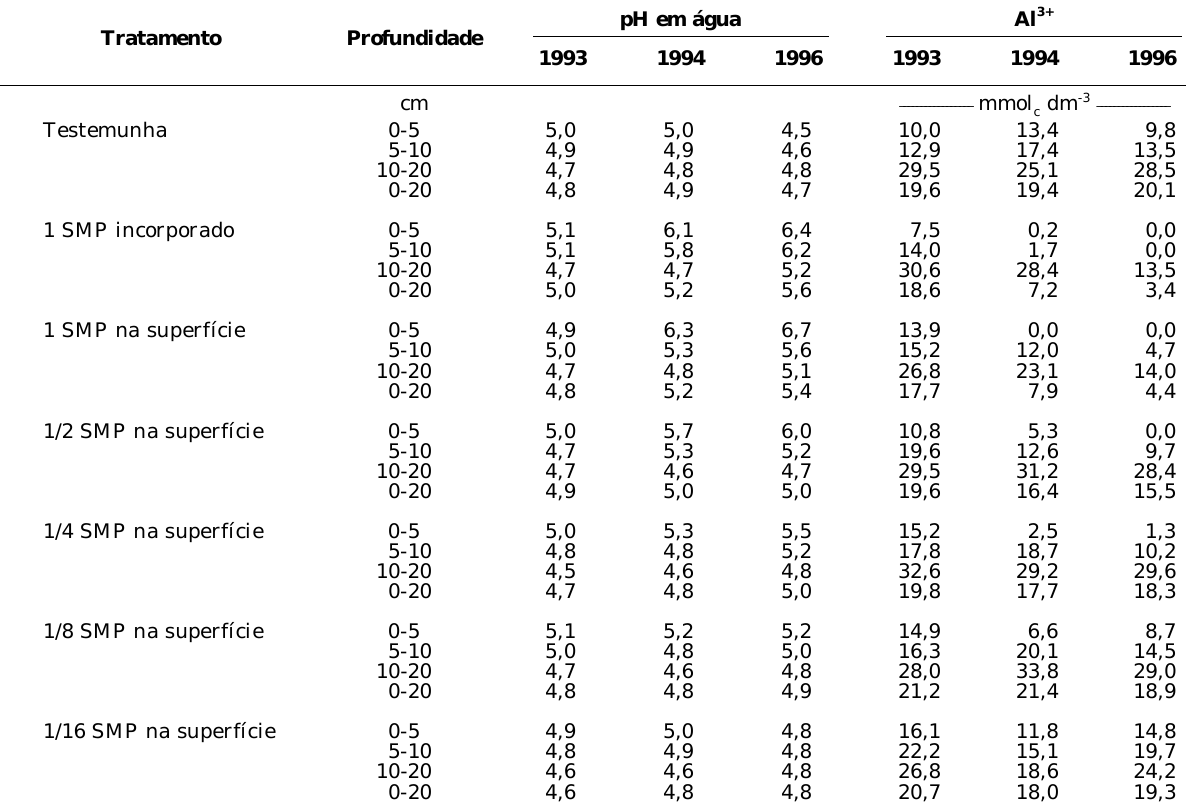
Quadro 4. Valores de pH em água e de alumínio trocável observados no LEd (Passo Fundo), antes, aos 11 e 34 meses da aplicação do